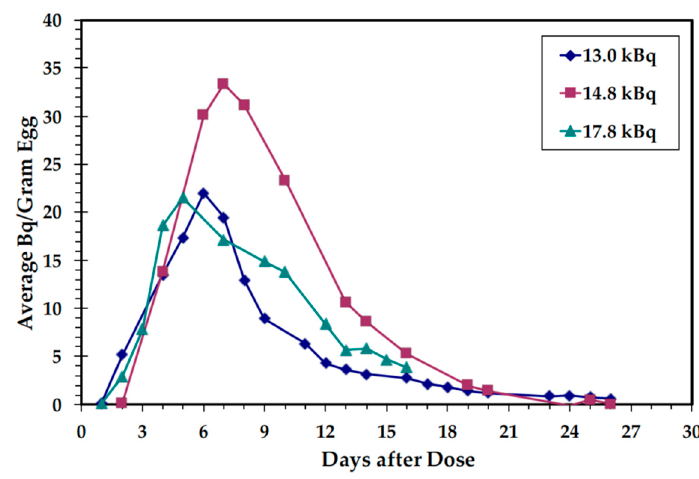
Figure 2. Time course of 14 C-B12 enrichment of study eggs. The series indicate the 14 C-B12 doses received by different hens.